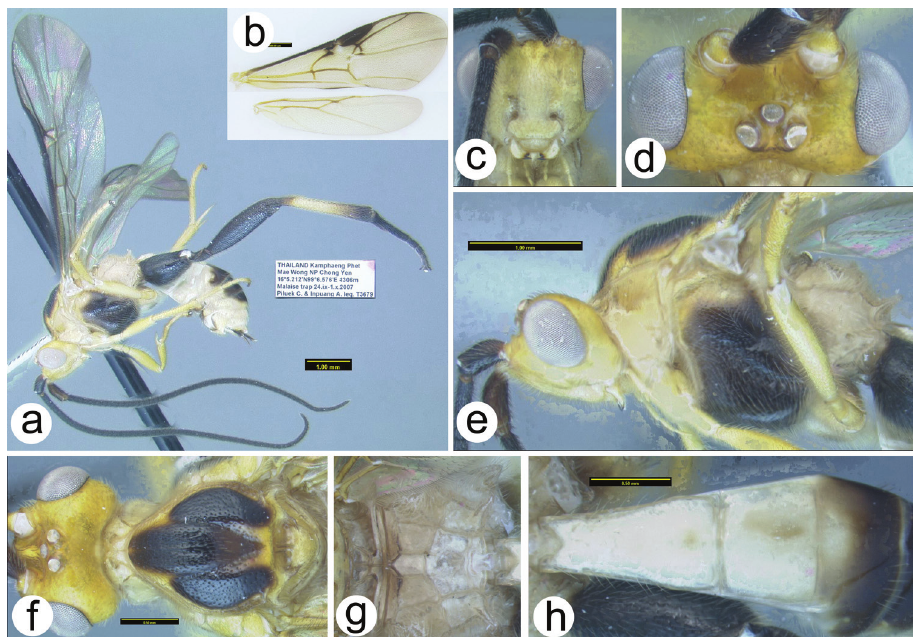
Figure 19. Zelodia uthaii sp.n. a lateral habitus b wings c anterior head d dorsal head e lateral head and mesosoma f dorsal head and mesosoma g dorsal propodeum h dorsal